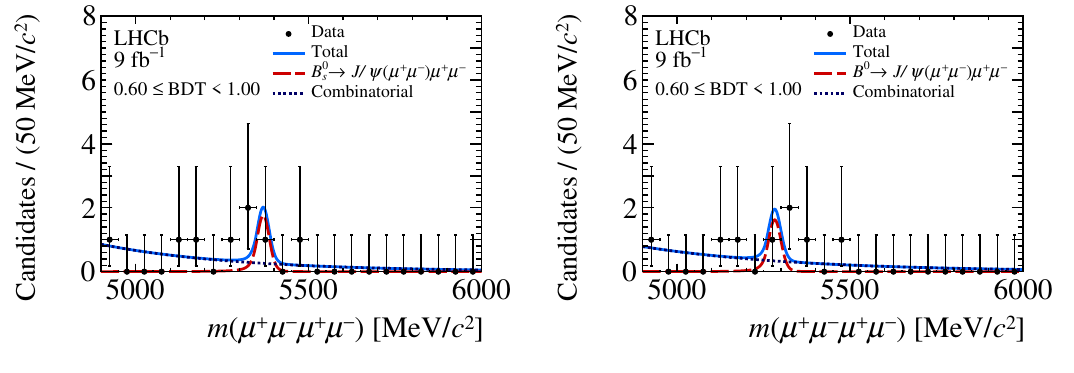
Distribution of the µ + µ − µ + µ − invariant mass of candidates passing the B 0 → J/ψ ( µ + µ − ) µ + µ − selection in the most sensitive BDT interval, with the fit mod- ( s ) els used to determine the branching fractions of (left) B 0 B 0 → J/ψ ( µ + µ − ) µ + µ − decays